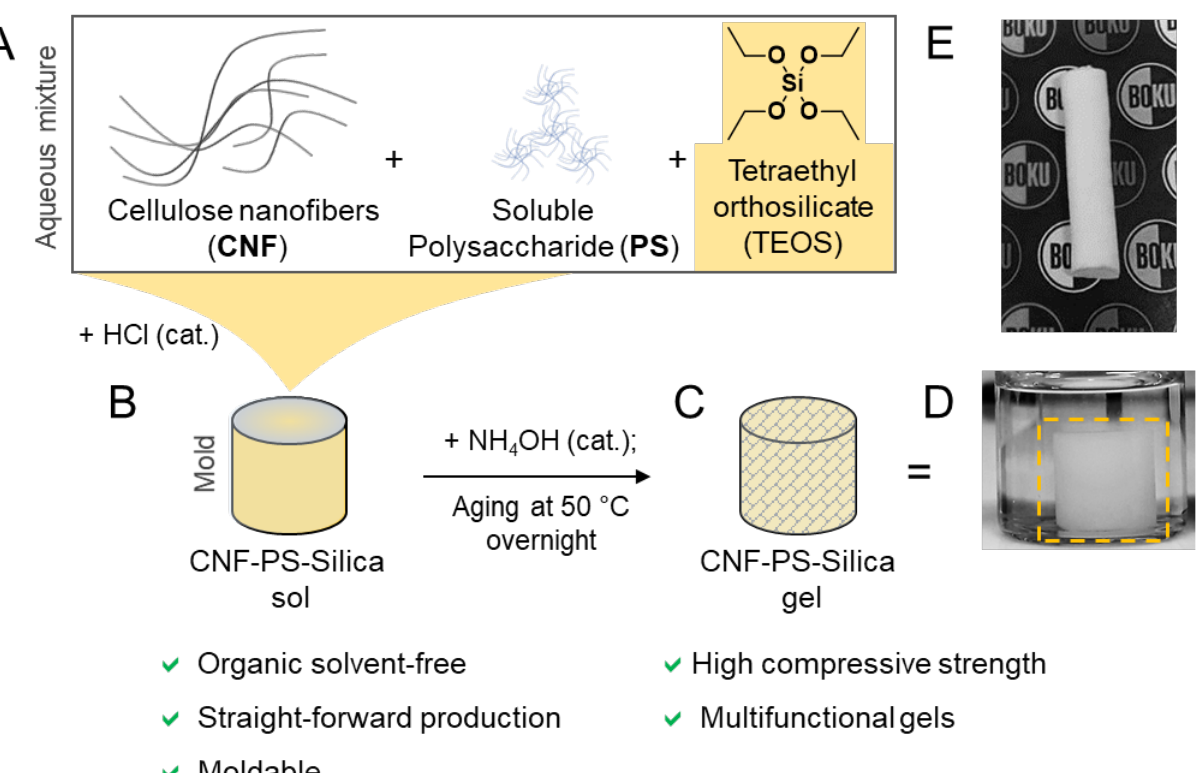
Figure 1. Preparation of silica composite gels reinforced with cellulose nanofibers (CNF) and a soluble polysaccharide (PS), starch, or methylcellulose. ( A ) The individual components are mixed in the presence of catalytic amounts of HCl to catalyze the hydrolysis of tetraethyl orthosilicate (TEOS). ( B ) Subsequently, ammonia is added to increase the pH and trigger the condensation and, thereby, the gelation of the sample. This was followed by the aging of the samples at 50 ◦ C to stiffen the gel network and obtain the final CNF–PS–Silica gel ( C ). The respective hydrogel ( D ) was dried by freeze-drying after solvent exchange to obtain highly porous CNF–PS–silica cryogels ( E ). The shape of the gel can be controlled through molding or 3D printing of the CNF – PS – silica sol.